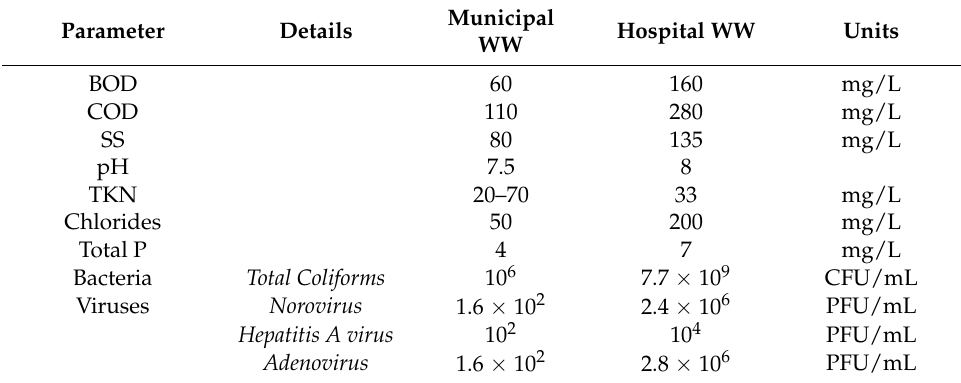
Table 1. Comparison between indicative MWW and HWW effluents characteristics [31,35,36] and references